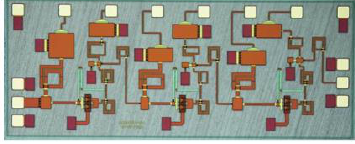
Figure 18 : Manufactured LNA die photo. Size is 2.8 x 1.3 mm